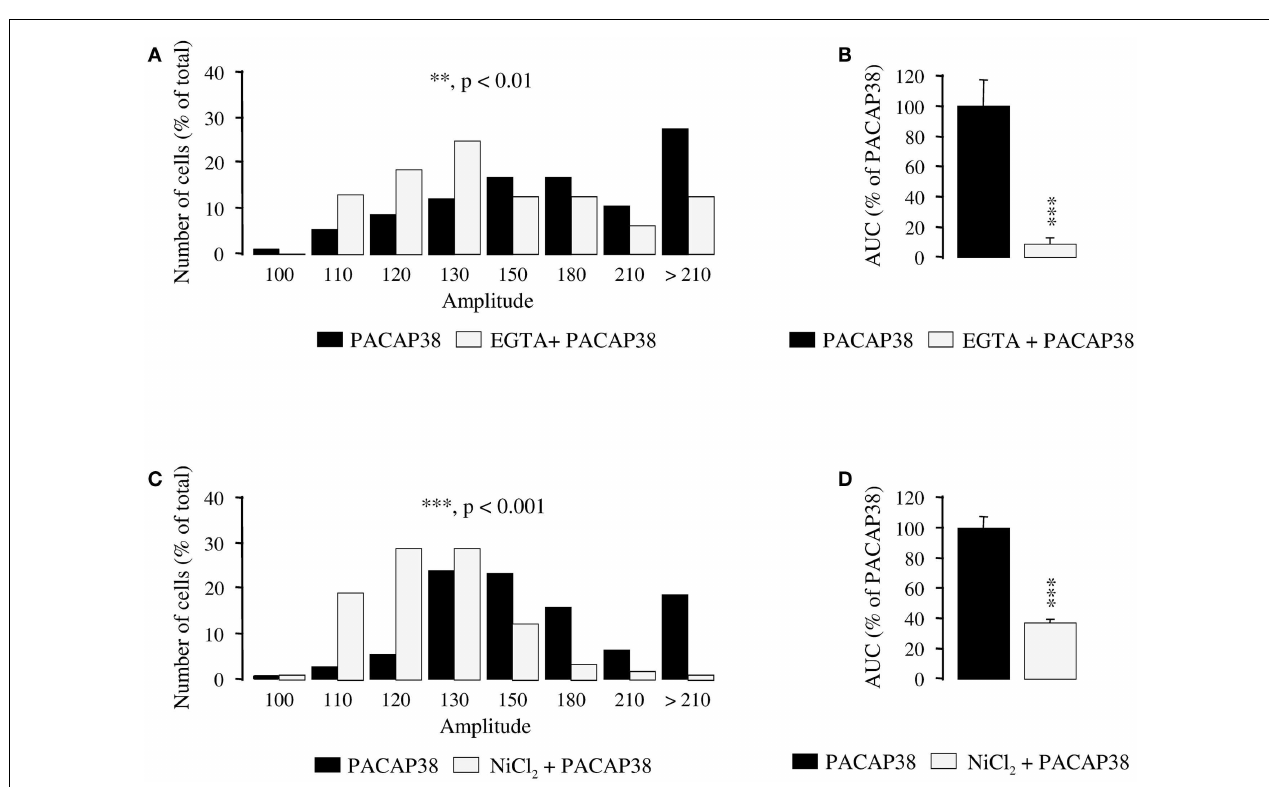
10min before application of the pulse of PACAP. (A,C) Histograms showing the distribution of granule cells according to the amplitude of their response to PACAP. Each graph represents the analysis of a least 50 cells from 3 different cultures. AUC, area under the curve; EGTA, ethylene glycol-bis( β -aminoethylether)-N,N,N (cid:48) ,N (cid:48) -tetraacetic acid; NiCl 2 , nickel chloride. ** p < 0.01, *** p <